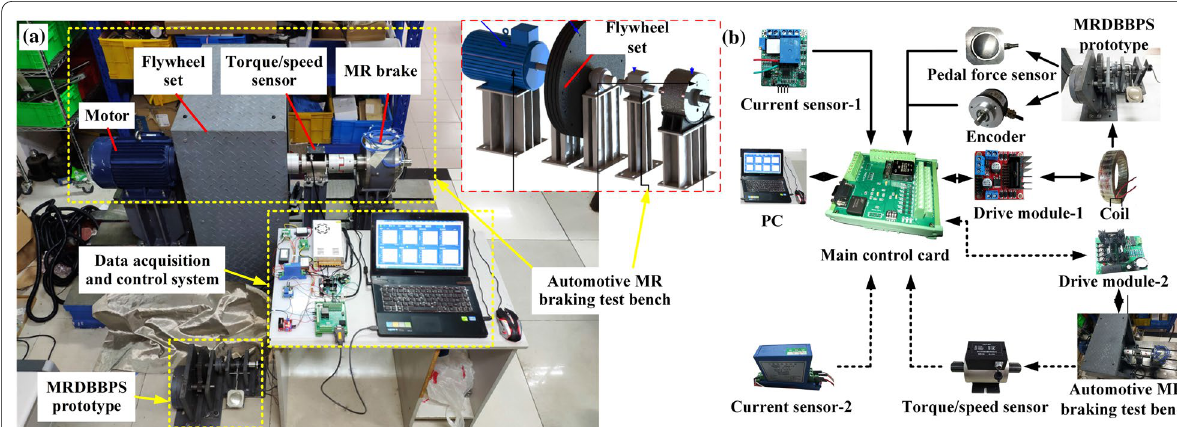
Table 1 Main design parameters of the AMRBTB Design parameter Value